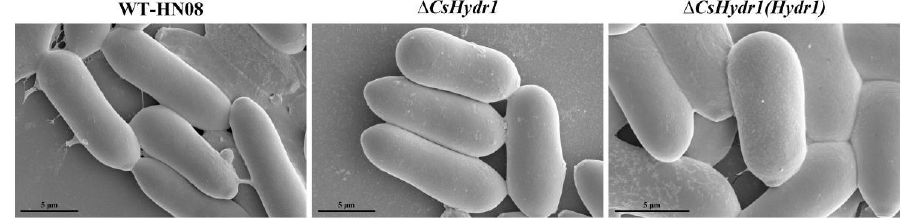
Figure 4. Electron microscopy of spore surfaces of HN08, Δ csHydr1 mutant, and Δ csHydr1(Hydr1) strain. Bars, 5 µm.